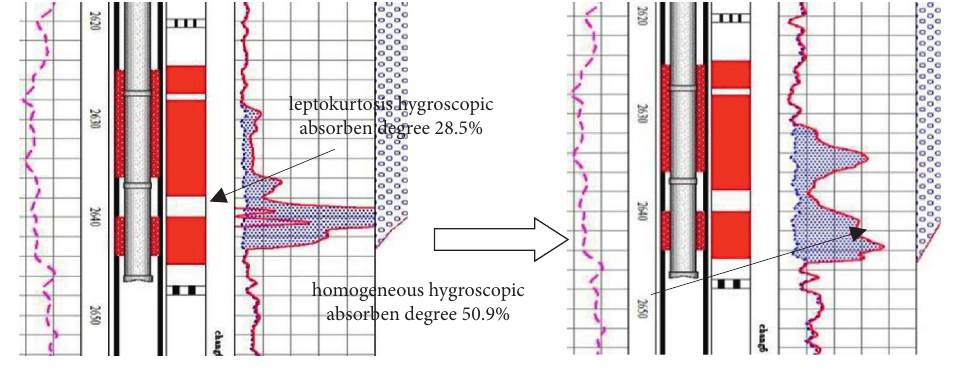
Figure 6: Absorption profile of the H5 well.